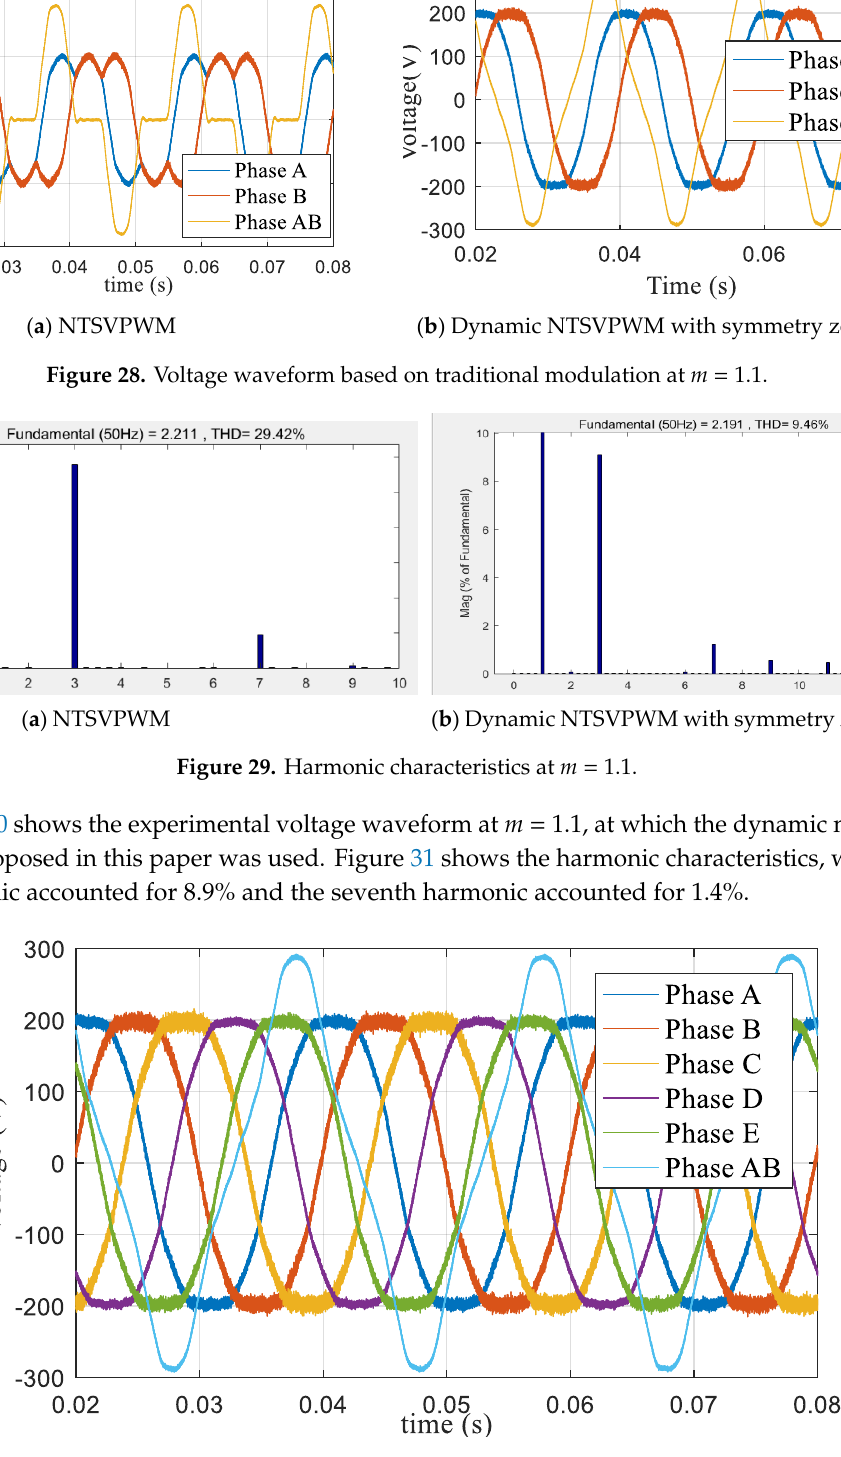
Figure 30. Voltage waveform based on the proposed dynamic modulation algorithm at m = 1.1.